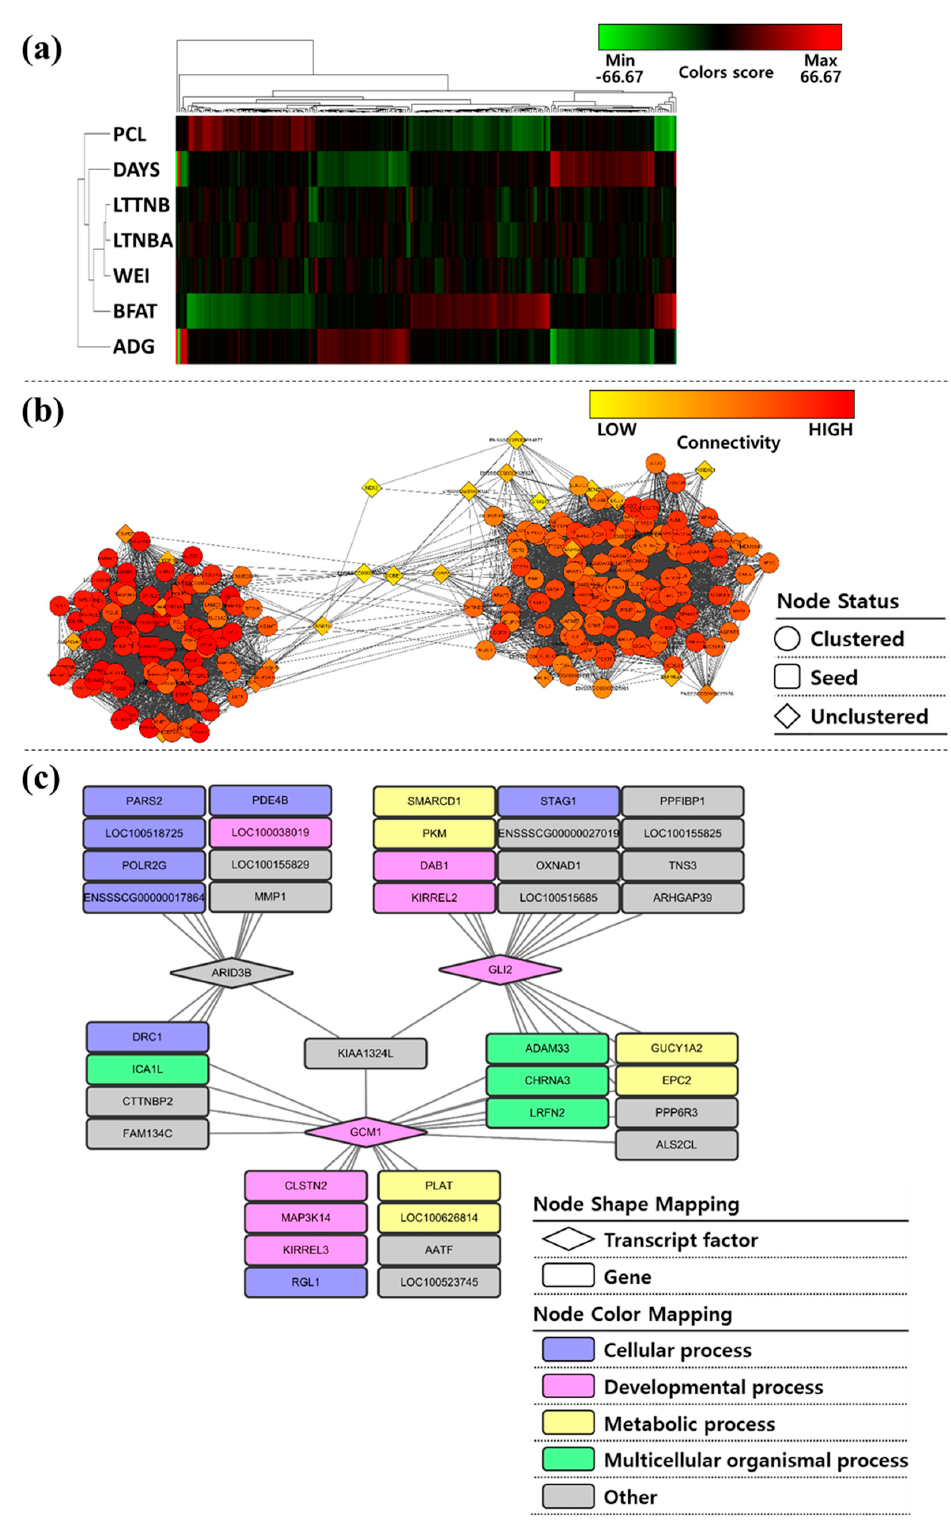
Figure 2. Functional gene network from the genome-wide association study using association weight matrix (AWM). ( a ) Visualizing the AWM using permutmatrix software. Each cell ( i, j ) is the z-score normalized additive effect of i th-trait on j th-SNP. ( b ) Entire network: The nodes represent 226 genes and the 6,921 edges represent significant correlations between the nodes. The color scale corresponds to the MCODE score, where the red nodes represent a high network density. ( c ) A subset of the network showing the top three transcription factors in the in silico validated targets. The diamond-shaped nodes are transcription